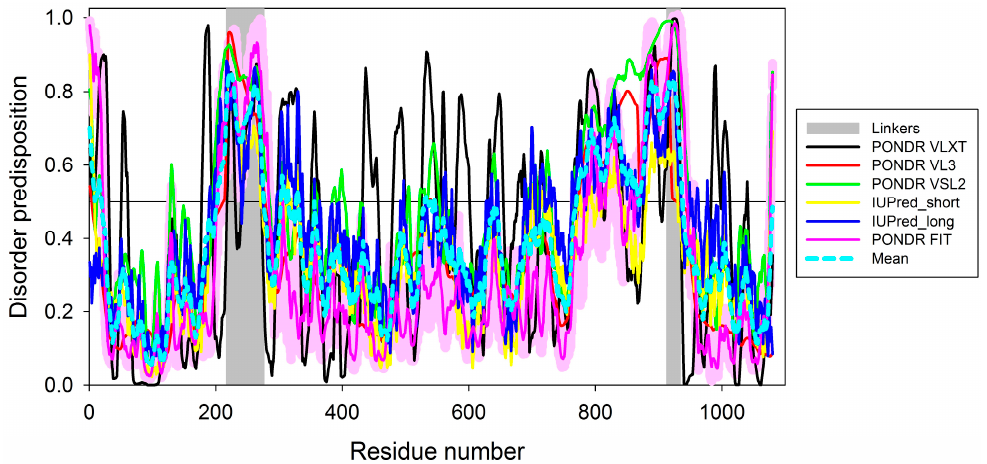
Figure 5. Evaluation of the intrinsic disorder propensity of the HSP70/EIII chimeric protein by a set of disorder predictors. Bold dashed dark cyan line shows the mean disorder propensity calculated by averaging the disorder profiles of individual predictors. Light pink shadow around the PONDR FIT curve shows the error distribution. Linkers connecting the DsbC domain, HSP70 protein, and EIII domain (residues 217–276 and 913–934) are shown by light gray bars. In these analyses, the predicted intrinsic disorder scores above 0.5 are considered to correspond to the disordered